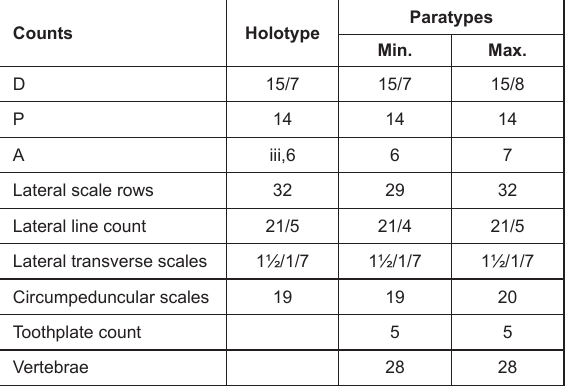
Table 2. Counts of Badis singenensis sp.